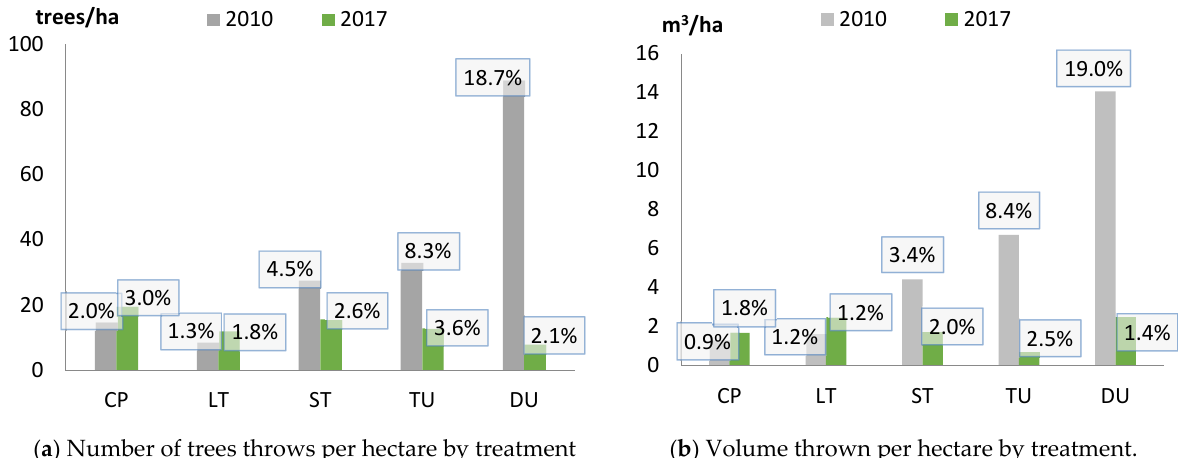
Figure 7. Effect of the windthrow events in 2010 and 2017 on treatment plots by treatment. The percentage corresponds to the proportion of thrown trees and thrown volume with respect to the corresponding total magnitude per ha.